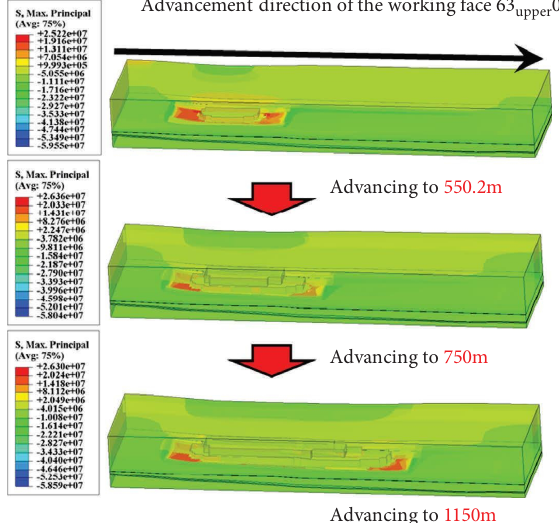
Figure 6: Cloud diagram of the maximum principal stress during the advance of the working face 63upper06.